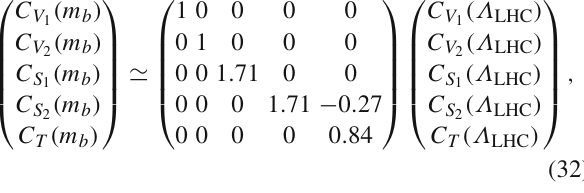
Fig. 4 Summary of the flavor and LHC bounds of the WCs at μ = m b alongwiththefutureprospectsattheHL-LHCwith3ab − 1 fromTable2. Unless the flavor bound indicates a favored direction on the complex